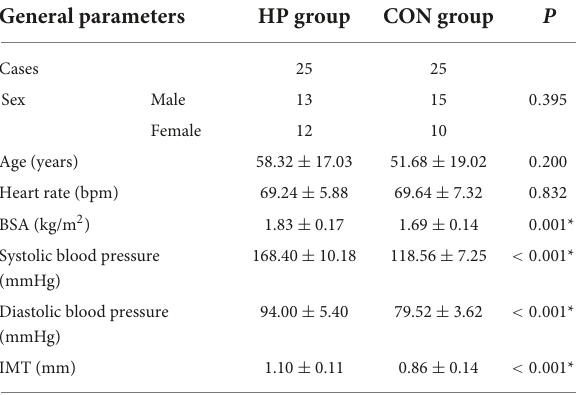
TABLE 1 General parameters of the HP and CON groups.